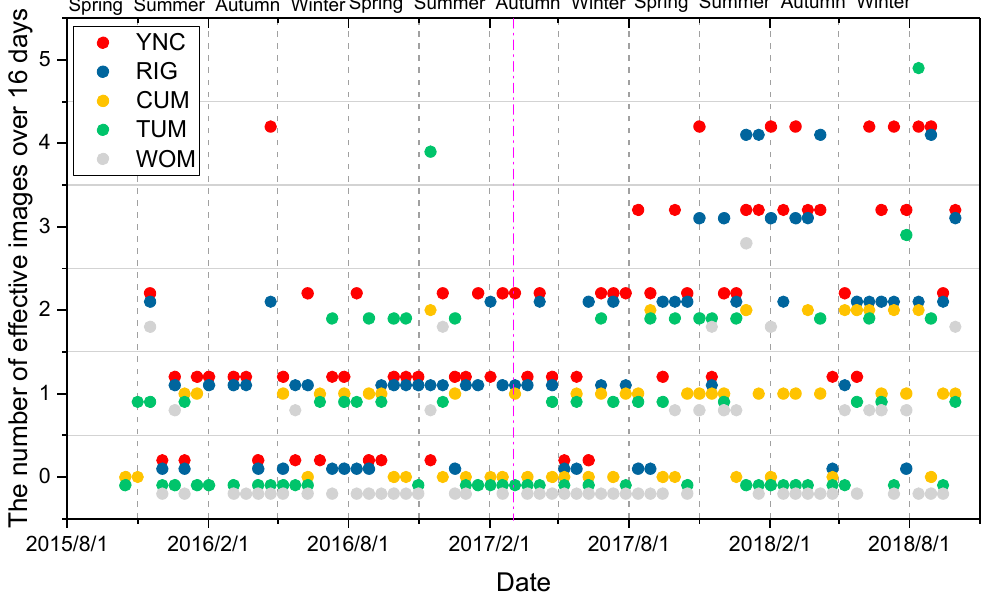
Figure 3. The number of effective Sentinel-2 images obtained during the 16-day interval. An effective image here is defined as an image with less than 10% cloud cover. The legend on the top left represents the abbreviation for each site. The bottom x -axis is the date, and the top x -axis is the season in Australia. The pink dashed line is the launch date of Sentinel-2B.